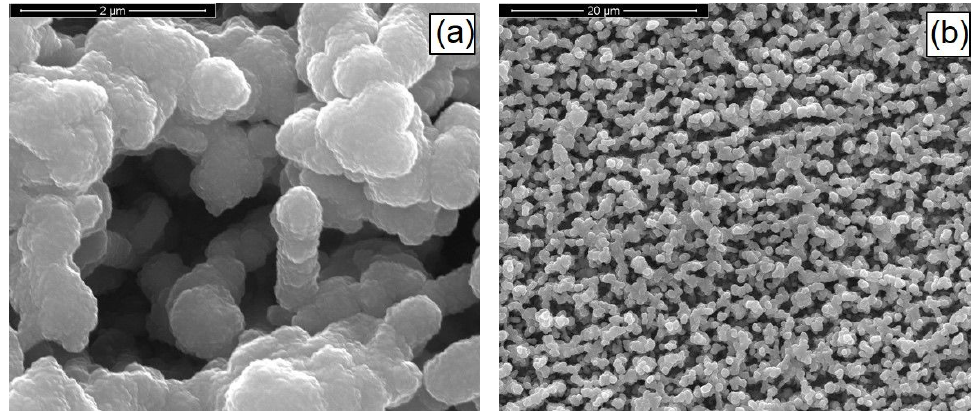
Figure 14. ( a ) High- and ( b ) low-magnification SEM images after the deposition of ZnO/AZO film. CZTSe NWs were obtained at pH = 3 with a copper content of 1 mM.